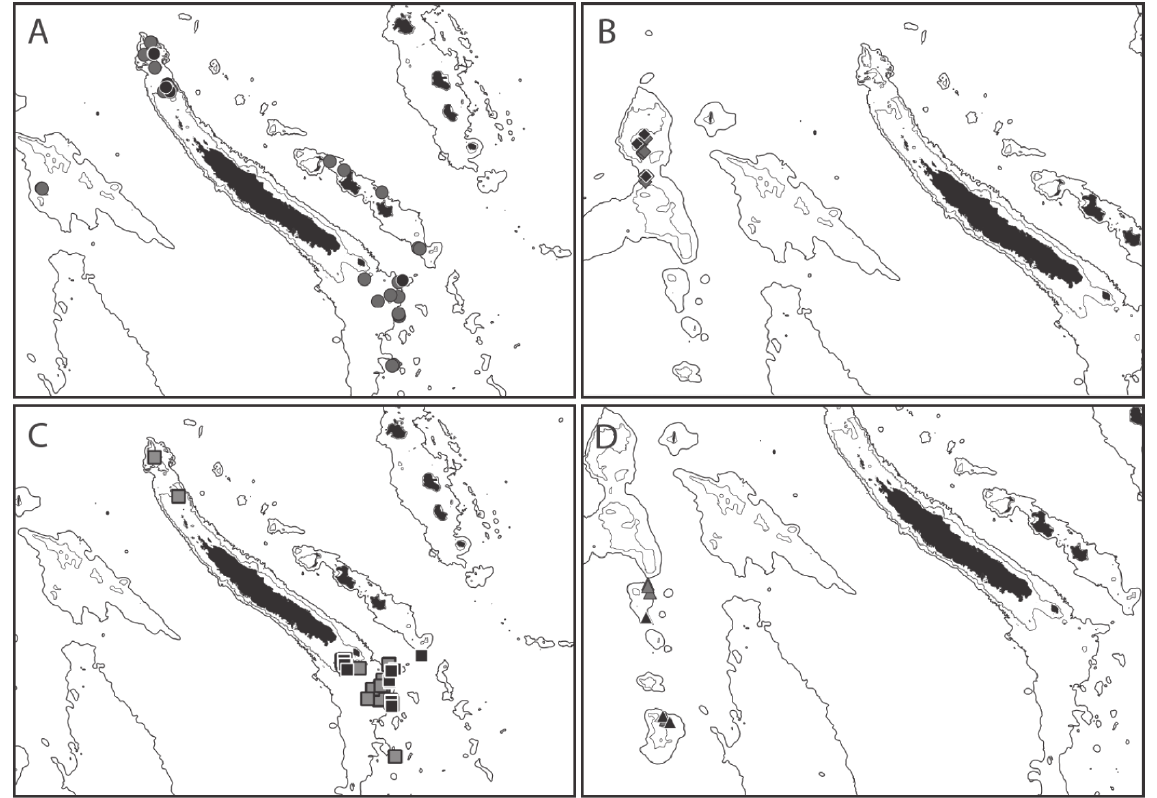
Fig. 1. distribution maps of the four species. A . Perotrochus wareni sp. nov . B . Perotrochus deforgesi Métivier, 1990. C . Perotrochus caledonicus Bouchet & Métivier, 1982. D . Perotrochus pseudogranulosus sp. nov . stations with sequenced specimens in